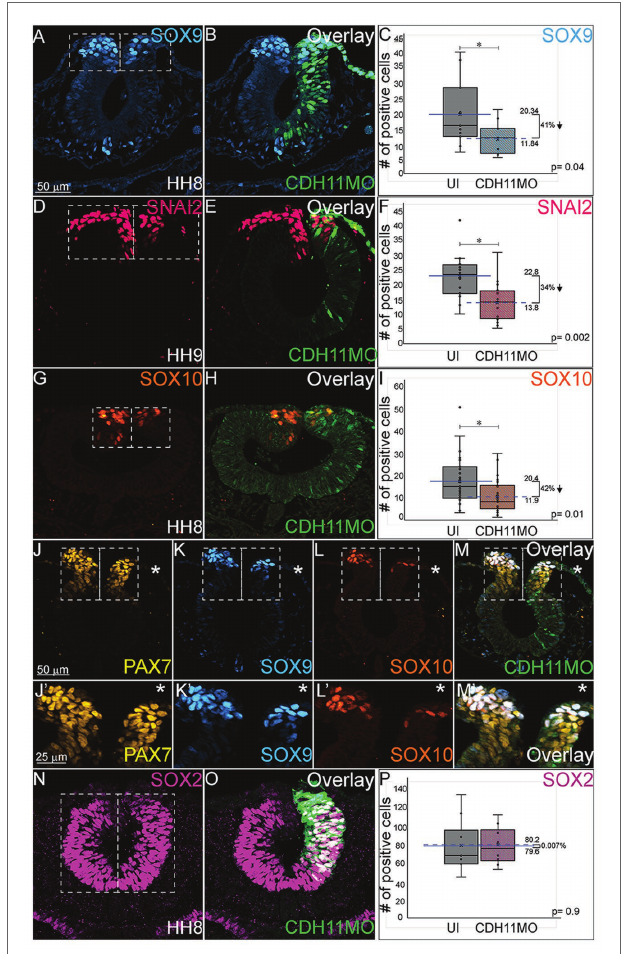
FIGURE 3 | Loss of CDH11 reduces definitive NC cells. To determine if loss of CDH11 affected neural progenitors and definitive NC cells in addition to NC progenitors, embryos were injected with CDH11MO or ContMO and electroporated, and IHC was performed for definitive NC cells (SOX9, SNAI2, SOX10) and neural progenitors (SOX2). (A) IHC for SOX9 in transverse section from HH8 embryo with (B) overlay with CDH11MO (green). (C) Graph showing difference between uninjected and CDH11MO-injected sides. Mean number of SOX9+ cells is 20.34 on uninjected and 11.85 on CDH11MO- injected side, p = 0.04, n = 11. (D) IHC for SNAI2 in transverse section from HH9 embryo with (E) overlay with CDH11MO (green). (F) Graph showing difference between uninjected and CDH11MO-injected sides. Mean number of SNAI2+ cells is 22.75 on uninjected and 13.75 on CDH11MO-injected side, p = 0.001, n = 16. (G) IHC for SOX10 in transverse section from HH8 embryo with (H) overlay with CDH11MO (green). (I) Graph showing difference between uninjected and CDH11MO-injected sides. Mean number of SOX10+ cells is 20.35 on uninjected and 11.87 on CDH11MO-injected side, p = 0.01, n = 18. (J–M’) Overlay from the same embryo to demonstrate reduction in NC progenitors (PAX7) and definitive NC cells (SOX9, SOX10) after CDH11 MO-injection ( n = 8/9 embryos with reduced cells). (N) IHC for SOX2 in transverse section from HH8 embryo with (O) overlay with CDH11MO (green). (P) Graph showing difference between uninjected and CDH11MO-injected sides. Mean number of SOX2+ cells is 80.20 on uninjected and 79.50 on CDH11MO-injected side, p = 0.90, n = 5. All graphs show mean (indicated on graph) and median (line within graph). Scale bar for (A,B,D,E,G,H,N,O) indicated in (A) and scale bar for (J-M’) indicated in (J) . Reducing CDH11 significantly reduces the entire population of premigratory NC cells without affecting the SOX2-positive neural tube